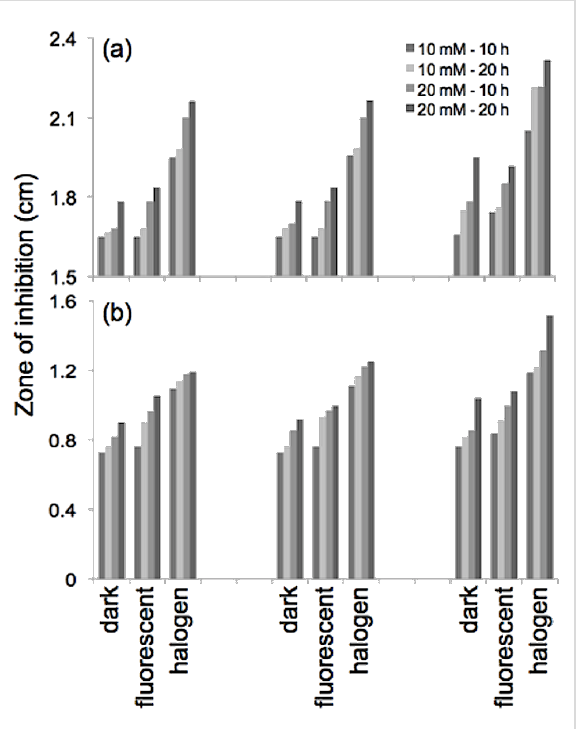
Figure 1: Increase in zone of inhibition for E. coli and S. aureus with increasing incubation time under dark conditions and upon light illumi- nation in the presence of antimicrobial paper. No zone of inhibition was observed for the control sample without ZnO nanorods. The antimicro- bial paper was more effective in immobilizing Gram-negative E. coli as they have a thinner cell wall compared to Gram-positive S. aureus .